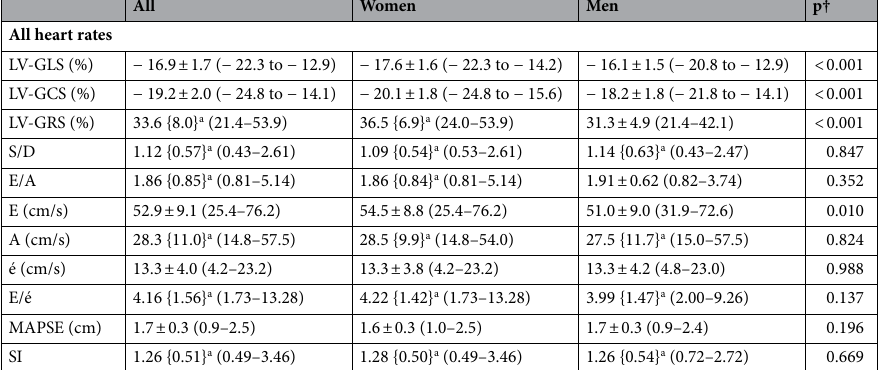
Table 4. Cardiovascular functional parameter of the total cohort. Normally distributed values were expressed as mean ± standard deviation, otherwise as median ( a ) with interquartile range. Ranges in parentheses. † p-value related to gender. Normally distributed data were tested by the unpaired t-test, otherwise with the Mann–Whitney-U-test. LV-GLS left ventricular global longitudinal strain, LV-GCS left ventricular global circumferential strain, LV-GRS left ventricular global radial strain, S/D ratio S-wave to D-wave by quantitative right upper pulmonary vein blood flow measurements, E/A ratio E-wave to A-wave by quantitative transmitral blood flow measurements, E E-wave by quantitative transmitral blood flow measurements, A A-wave by quantitative transmitral blood flow measurements, é mean lateral and septal cine CMR velocities, E/é ratio E-wave to é, MAPSE Mitral annulus plain systolic excursion, SI Sphericity index.